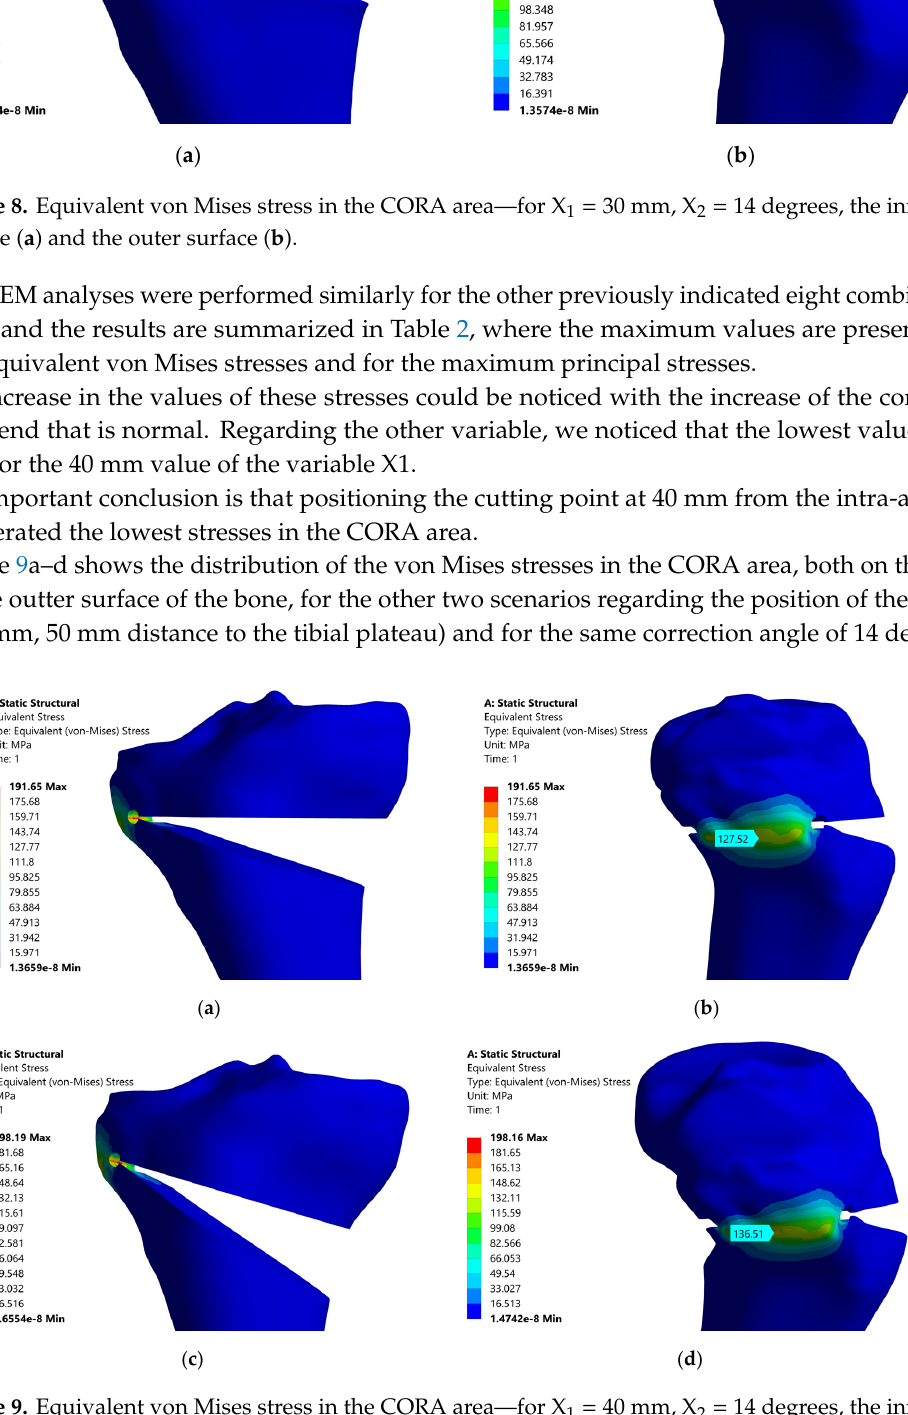
Figure 8. Equivalent von Mises stress in the CORA area—for X 1 = 30 mm, X 2 = 14 degrees, the inner surface ( a ) and the outer surface ( b ).